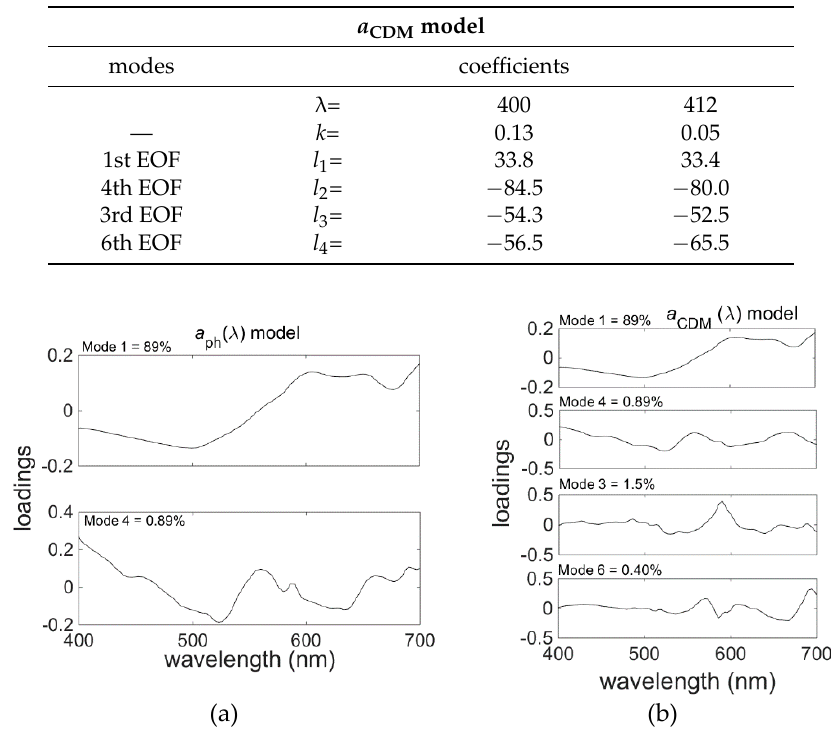
Table 8. Selected EOF modes and regression coefficients (4) of the a CDM model.